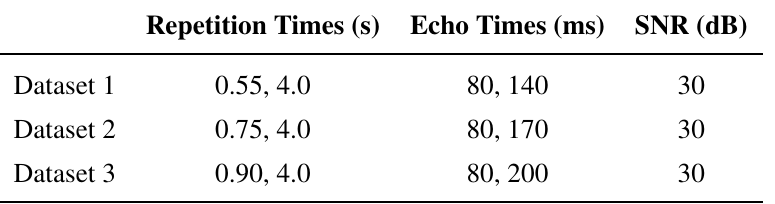
Table 6. Acquisition parameters: three datasets composed of four images.